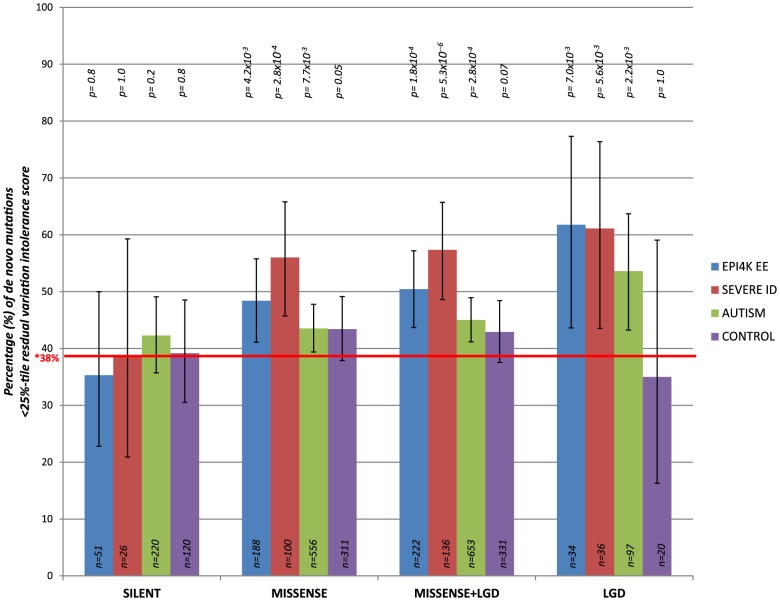
The percentage of de novo mutations occurring in the most intolerant quartile (25th percentile) across the severe ID, autistic, epileptic encephalopathy, and control siblings, for the different variant effect types.LGD = Likely Gene Disrupting (including nonsense, coding indels, and splice acceptor/donor site mutations). *Taking the CCDS of RVIS genes, 38% reflects the total real estate occupied by the 25th percentile most intolerant genes. P-values reflect binomial exact tests where the probability of success is adjusted to 0.38, accounting for the gene sizes of the 25% most intolerant genes.